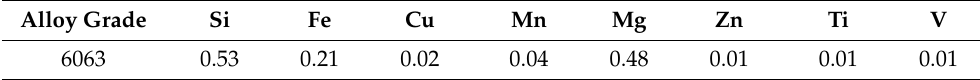
Table 2. Chemical composition of the test melt from 6063 aluminum alloys. Alloy Grade